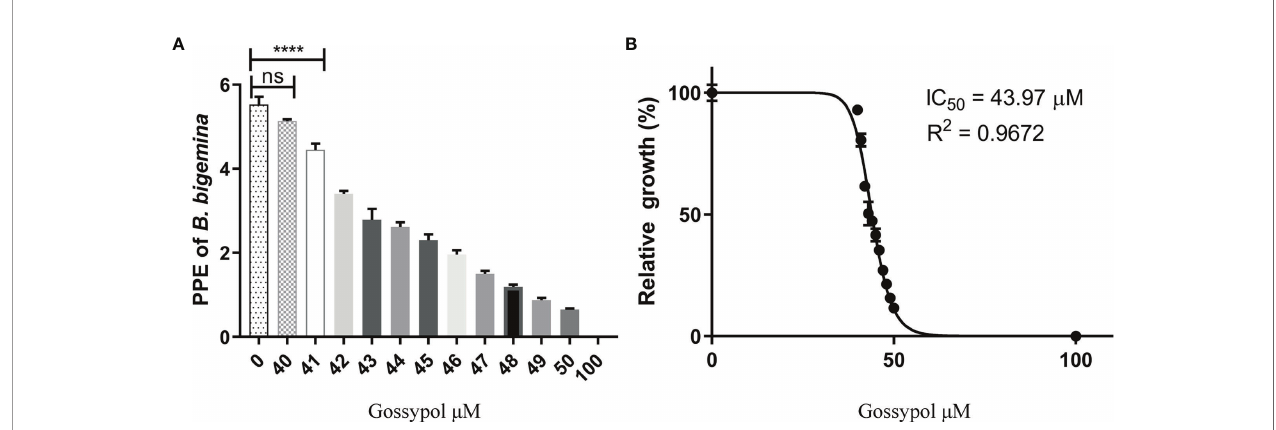
FIGURE 3 | Relative growth of different concentration gossypol treated B. bigemina . (A) Gossypol ef fi cacy in the growth of B. bigemina in vitro culture. Parasites were cultured at 5% cattle RBC until parasitemia is more than 3%. The cultures were diluted to 0.2% PPE and cultured with a total volume of 200 ml/well in 96-well plate in 5% CO 2 , treated with gossypol at different concentrations for 72 h. (B) IC 50 of gossypol in B. bigemina in vitro culture analyzed by Graphpad Prism7 with dose-inhibition calculation. ns represents no difference; Four asterisks (****) represent statistically signi fi cant differences and P < 0.0001. ns, no signi fi cant difference.